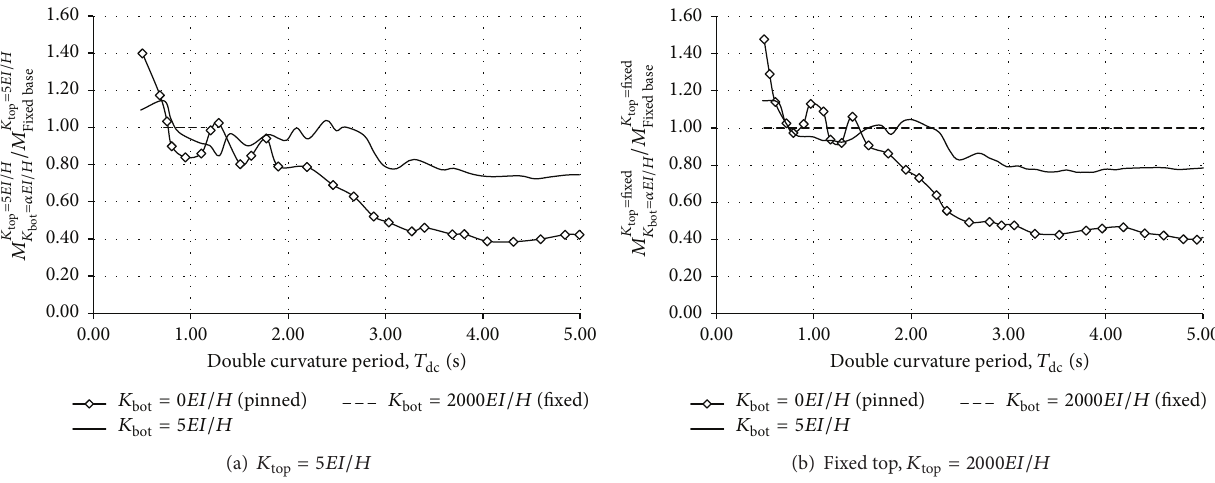
Figure 7: Base flexibility effect on elastic top moment for linear case.